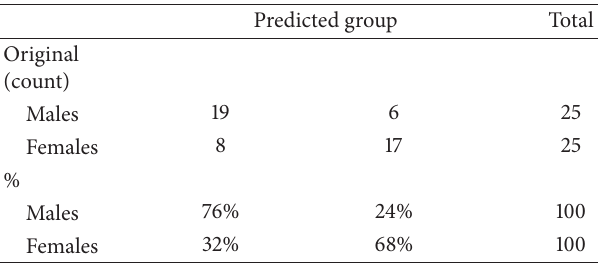
Table 3: Discriminant analysis showing specificity of 76% and sensitivity of